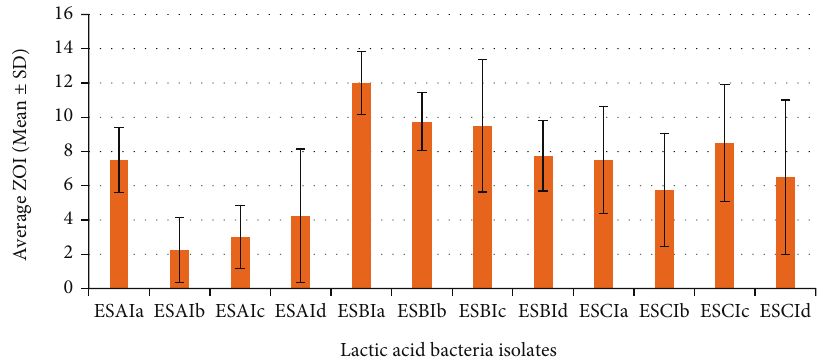
Figure 4: Average inhibition zones of LAB isolates against E. coli.